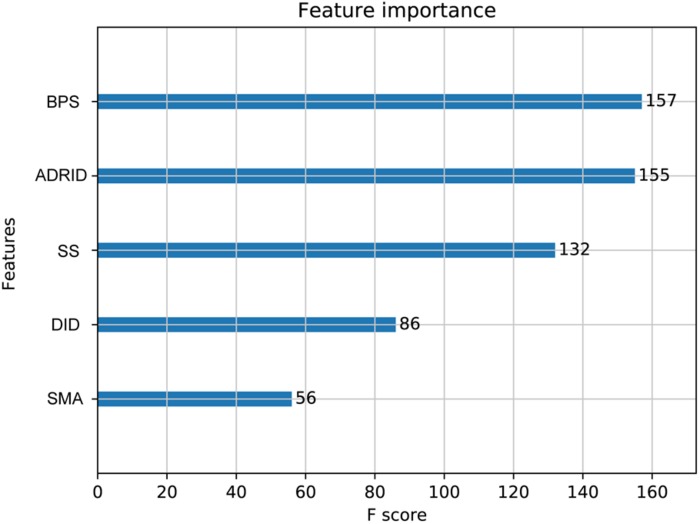
Feature importance contributed to the XGBoost model measured by F-score: The average F-score of each model is displayed from 50 repetitions of the fivefold cross-validation (CV) carried out in the training set. Features in order of their contributions from large to small are as follows: BPS, biological process similarity; ADRID, adverse drug reaction intersection degree; SS, separation score; DID, disease intersection degree; SMA, the similarity of mode of action.